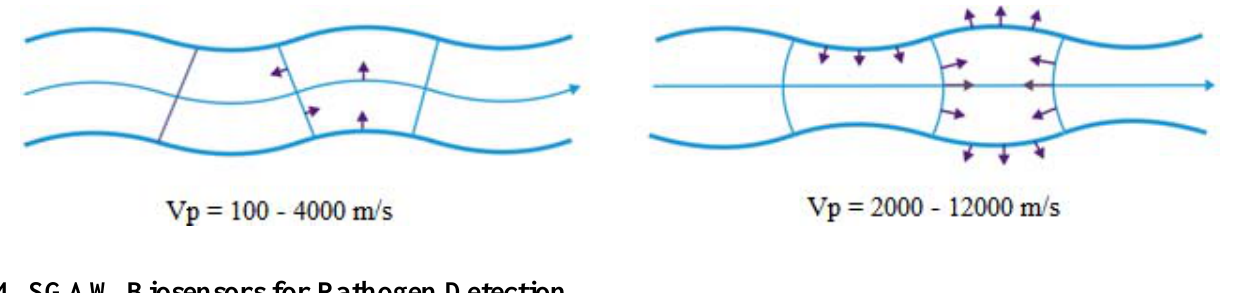
Figure 18. Pictorial representation of Lamb wave modes: (left) antysimmetric mode and (right) symmetric mode. Typical wave speeds, Vp, are shown below each